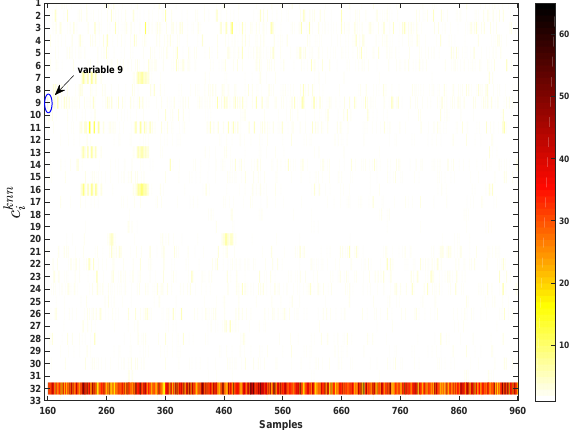
Figure 12. The variable contribution by kNN for fault 4 of